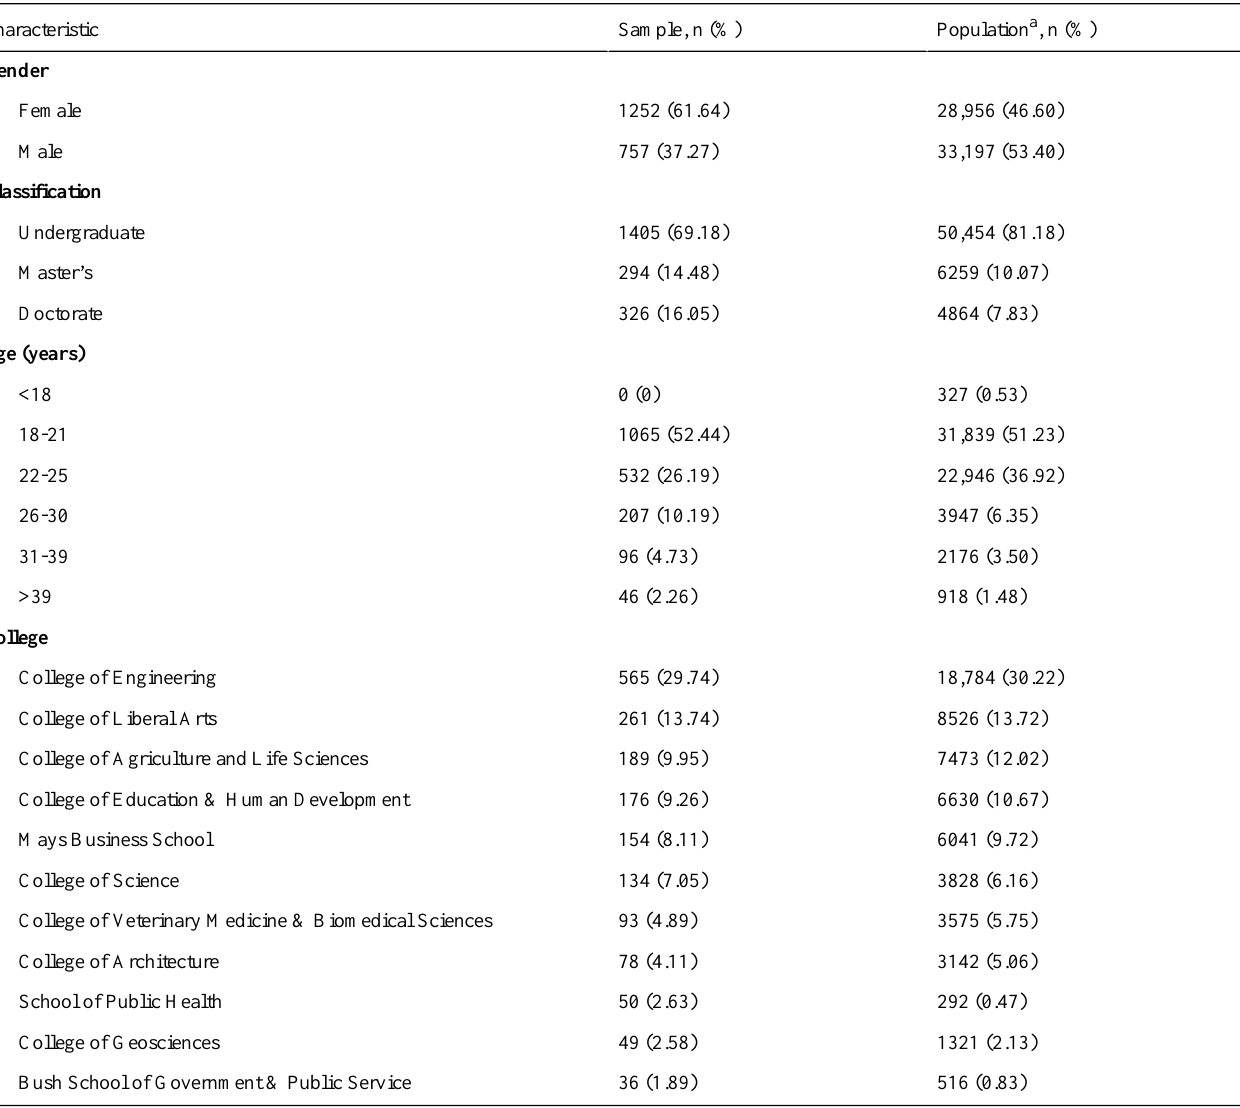
Table 1. Demographics.